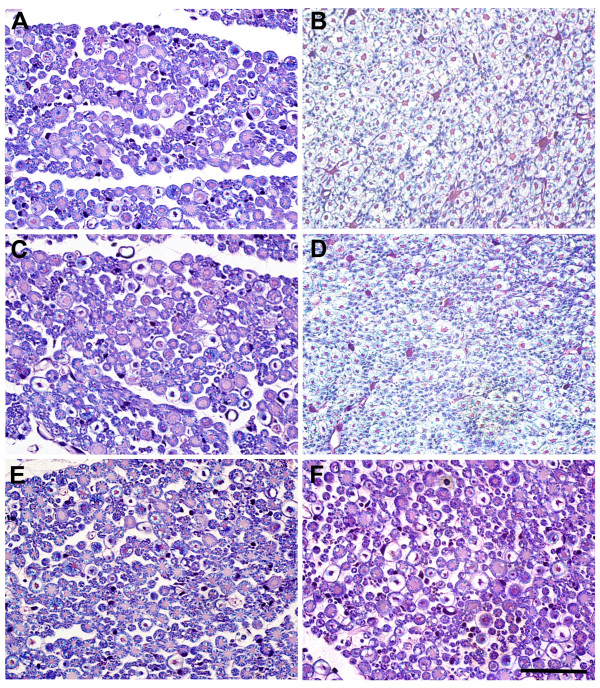
The morphological changes in the trigeminal nerve root following microinjection of LPA. On postoperative day 1 (A, B) and 14 (C, D), luxol fast blue stained light micrographs reveal severe demyelination of axonal portion of the trigeminal nerve root compared with vehicle-injected root, respectively (E, F). LPA-induced demyelination was recovered on postoperative day 160. Scale bar, 50 μm.